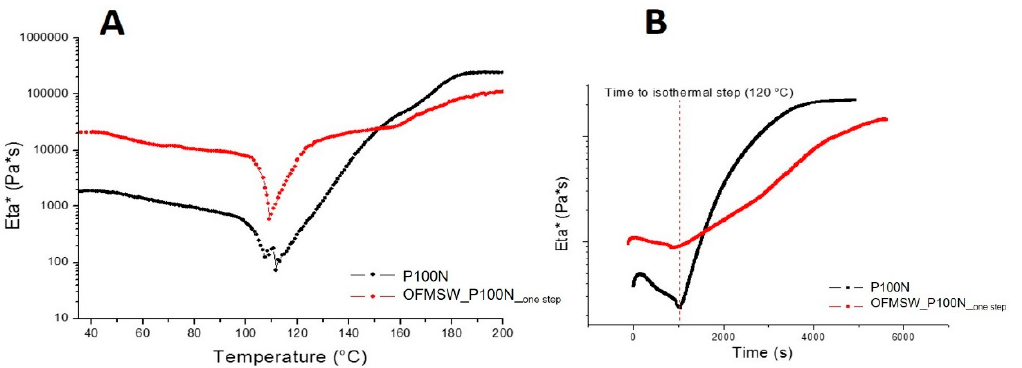
Figure 6. ( A ) Dynamic rheological curve of P100N and OFMSW_P100N_one step; ( B ) isothermal Figure 6. A) Dynamic rheological curve of P100N and OFMSW_P100N_one step; B) isothermal rheological curves at 120 ◦ C of P100N and OFMSW_P100N_one rheological curves at 120 °C of P100N and OFMSW_P100N_one step .